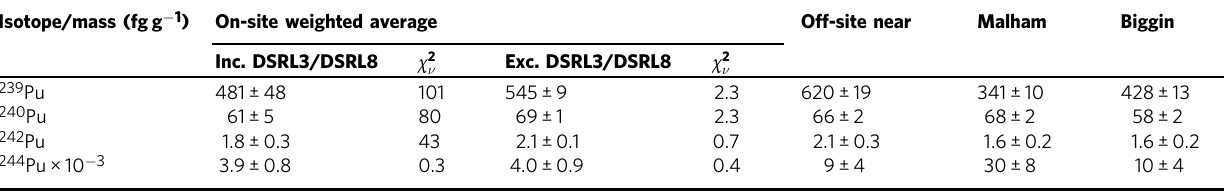
For samples from on-site at Dounreay, off-site but near to Dounreay (off-site-near) and ~700km distant (off-site-far: Malham and Biggin). Errors quoted are the error of the mean. Data for on-site samples are presented with and without the DSRL3 and DSRL8 outliers and the corresponding χ 2 ν